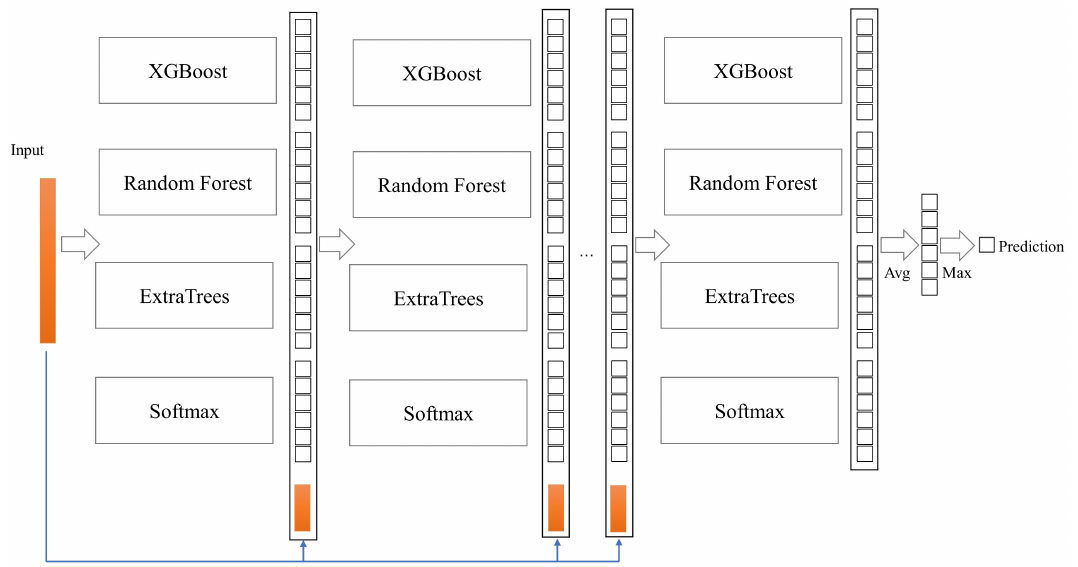
Figure 2. CELearning model. Each layer is composed of four basic classifiers which generate the probability vectors as augmented features for next layer’s